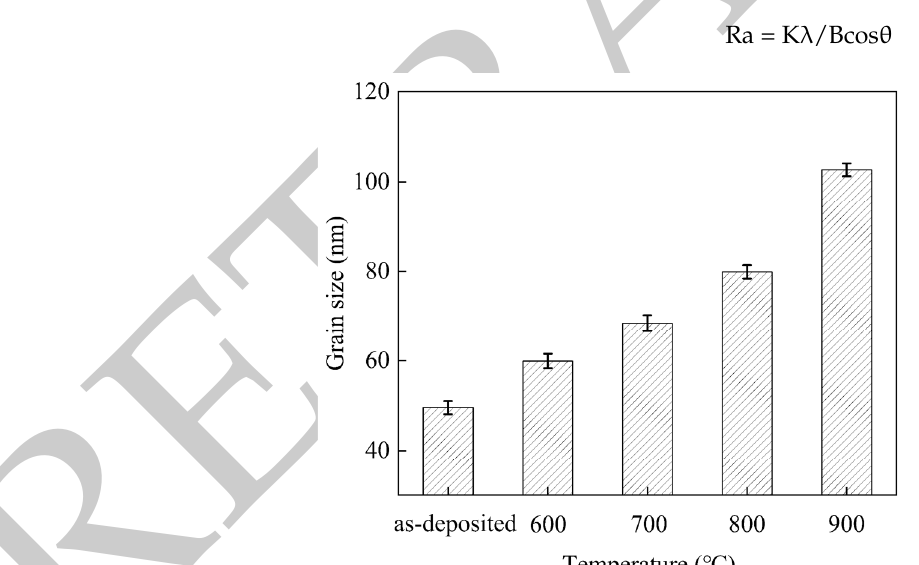
Figure 2. Average grain size of the AlTi 3 phase in the AlCrTiSiN coatings before and after annealing at different temperatures.